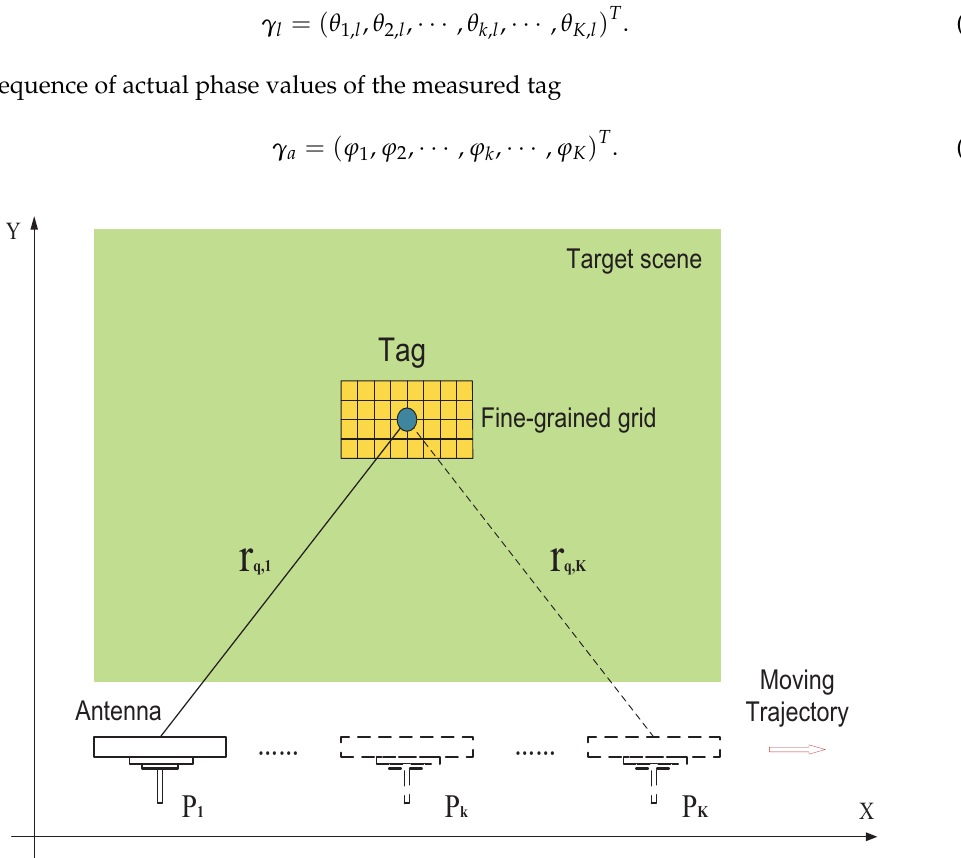
Figure 3. RF-SML localization model (the reader antenna moves along the x-coordinate